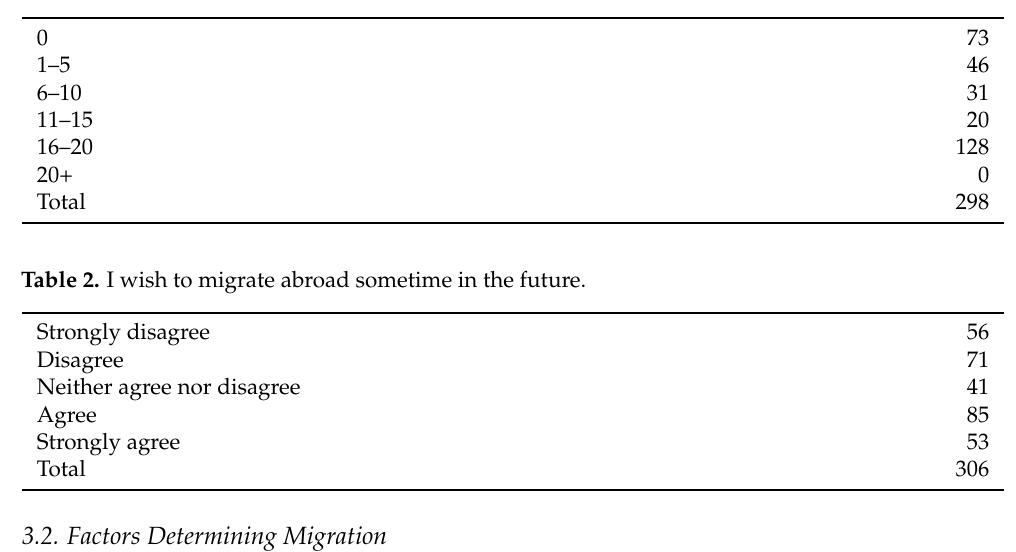
Table 1. Family members living abroad.